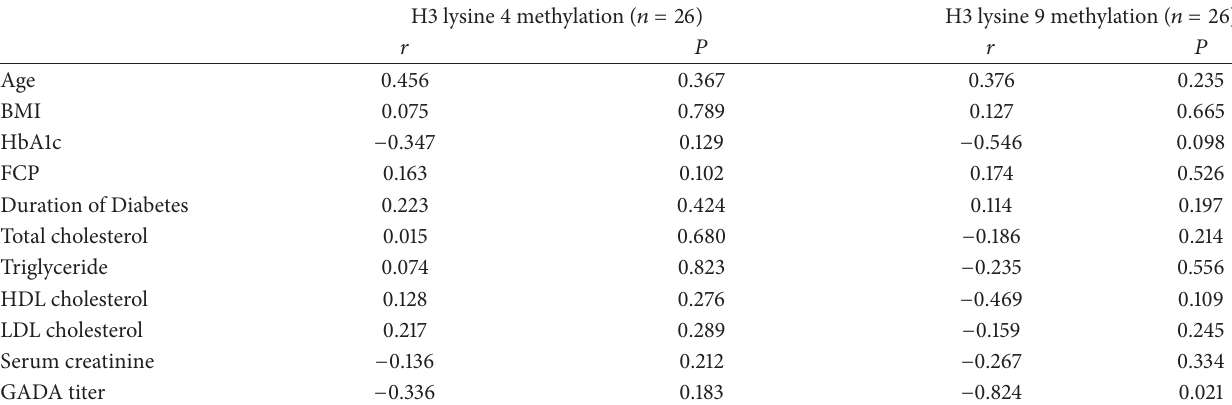
Table 3: Correlation analysis of global histone H3 lysine 4 and H3 lysine 9 methylation in CD4 + T lymphocytes from LADA patients.